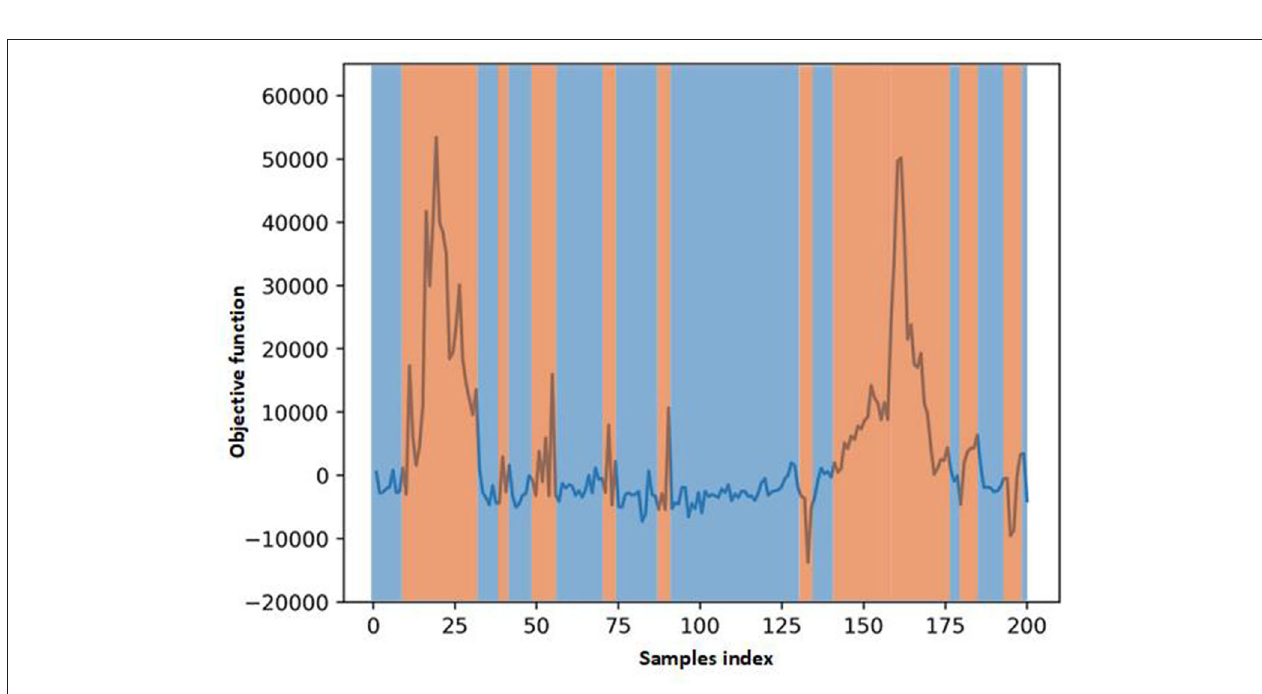
FIGURE 6 | Scores of objective function obtain by MAE. The score changes immediately when some different types ECG samples in the test